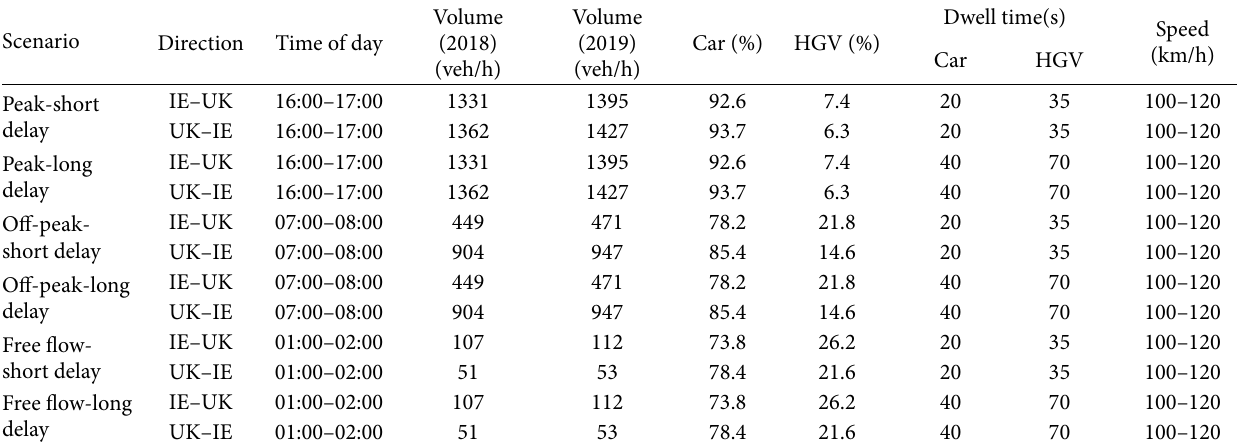
Table 3: Summary of scenario design values for CL1.